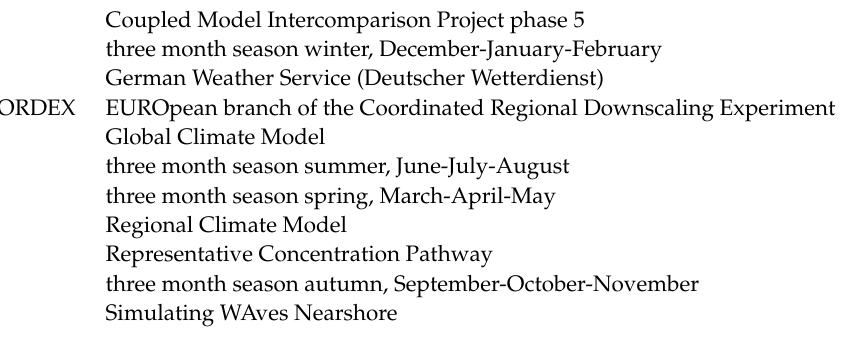
Table S8: 30-year annual (column “AVG”) and seasonal averages for RCP2.6 . . .